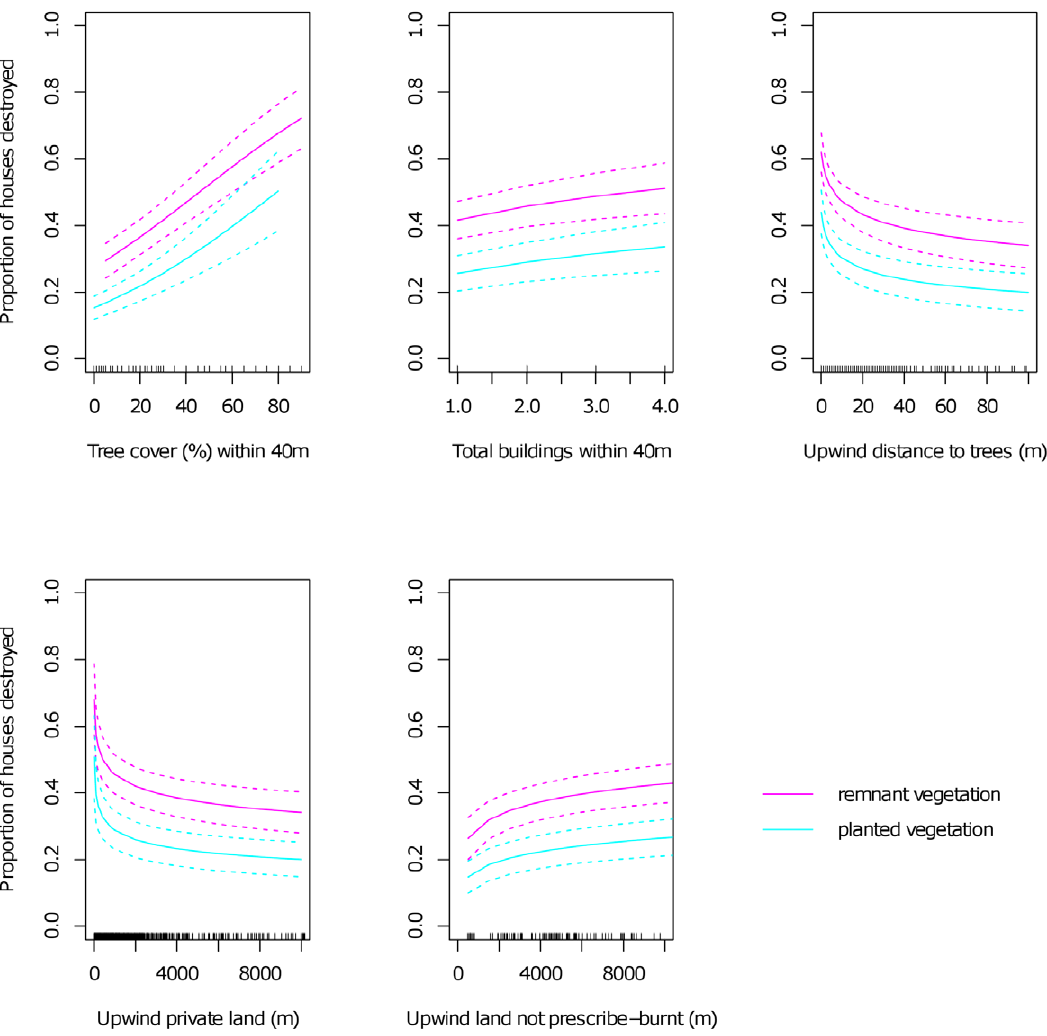
Figure 1. Individual effects (mean ± s.e.m.) of fuel variables in the logistic model used to predict the proportion of houses lost during wildfire. Each prediction was made with the other significant explanatory variables held at their means and FFDI fixed at 100, which is the value above which 64% of houses have been destroyed in wildfires in Australia [26]. Magneta (pink) lines are predictions for vegetation within 40 m of houses that is predominantly remnant native vegetation and cyan lines are predictions for vegetation within 40 m of houses that is predominantly planted vegetation.